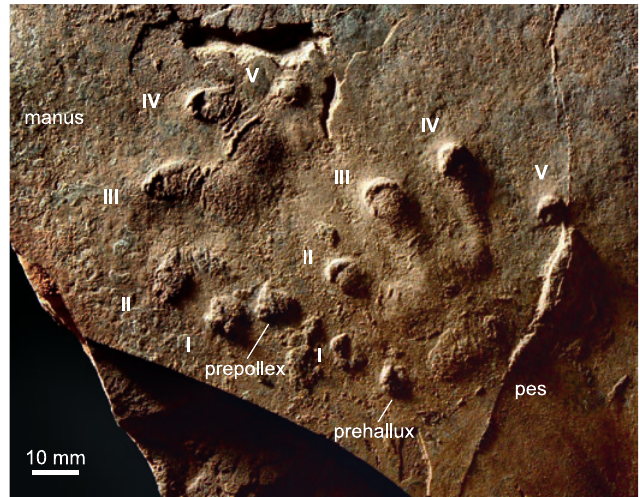
Fig. 15. The track Amphisauropus Haubold, 1970, NMMNH P-37922, cen- tral New Mexico, USA, Abo Formation, Cisuralian, left manus and pes im- print, convex hyporelief, presumably from a seymouriamorph